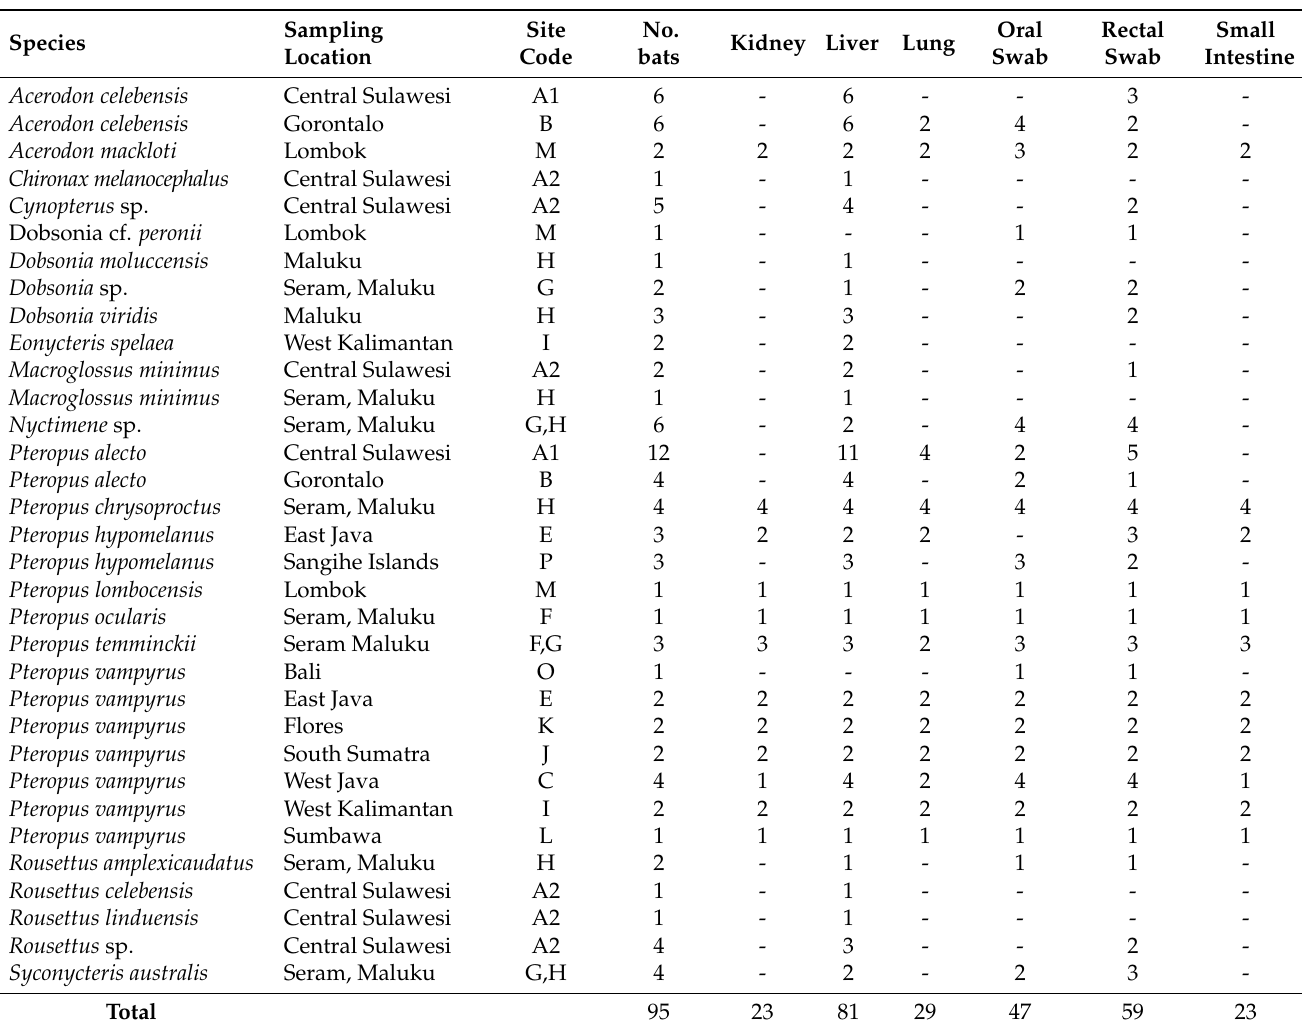
Figure 1. Locations of 17 sites across the Indonesian archipelago where tissues from pteropodid bats were sampled for viral screening. Location K is the site of the Pteropus vampyrus positive for Tioman virus. Table 1. Bat species, province, site code (with reference letter on map), number of bats, and sample types tested for paramyxoviruses with a conventional